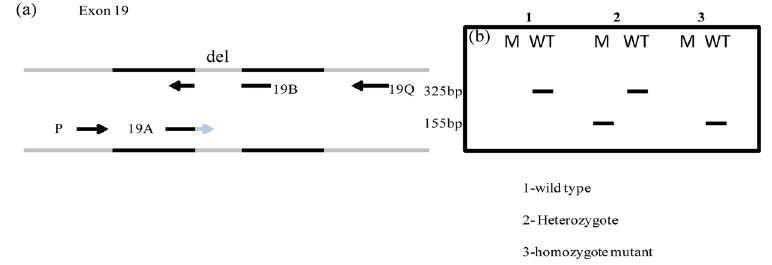
Figure 5. ( a ) Schematic illustration of designed Bi-PASA assay for the detection of exon 19 deletion. The deletion sequence variation is indicated by a light gray line. Two outer primers (P and Q) and two specific primers (A and B) are used to amplify specific products. Fragment sizes were: 155 bp for the deletion, 339 bp for the wildtype. ( b ). Predicted band pattern obtained with Bi-PASA genotyping. The AQ fragment can be amplified only with the wild-type sequence. PB can be amplified only in mutant DNA. A heterozygous genotype is characterized by both an AQ and PB amplification fragment. M = M tube. WT = WT